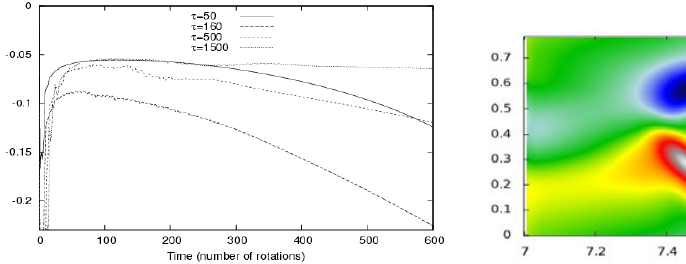
Figure 7. The Baroclinic term after 500 rotations for a disk with thermal di ff